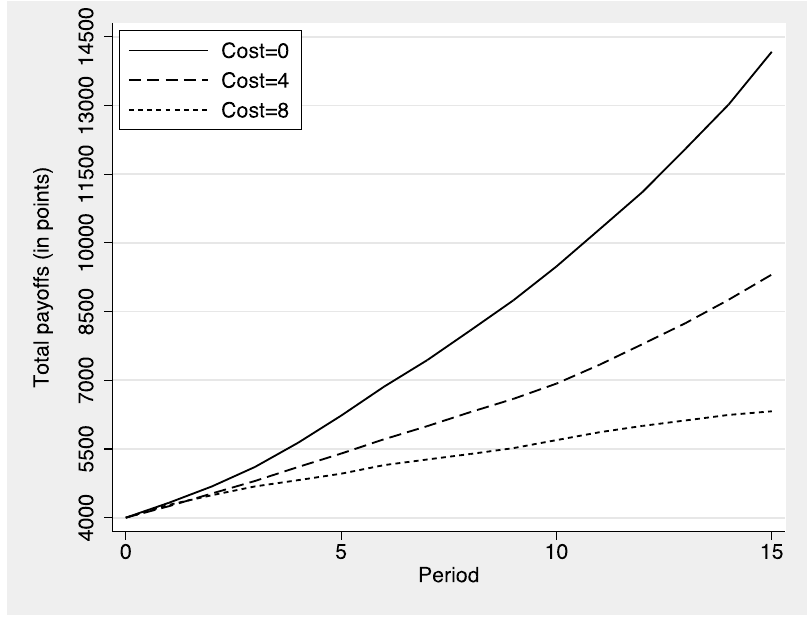
Figure 4. Total wealth in the population by period as a function of the cost required to discover information on partners. Participants start with an initial endowment of 200 points each.